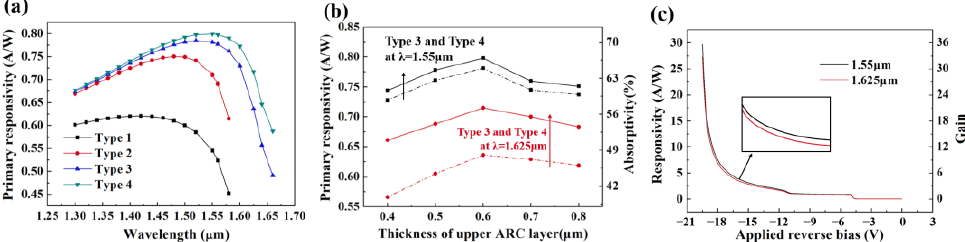
Figure 6. The primary responsivity of ( a ) four device types at various wavelengths and ( b ) type 3 and type 4 with different thicknesses of ARC layer at 1.55 and 1.625 μm wavelength. ( c ) DC photoresponsivity and gain vs. applied reverse bias voltage characteristics of type 4 at 1.55 and 1.625 μm wavelength.